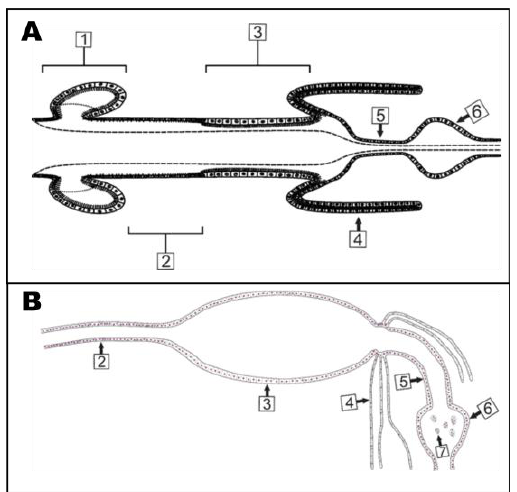
Figure 1. Anatomy of the larval and adult mosquito gut. ( A ) The larval alimentary canal is comprised of the foregut and cardia (not shown), GC (1), AMG (2), PMG (3), MTs (4), ileum (5), and rectum (6) (adapted from [5]); ( B ) The adult alimentary canal is comprised of the AMG (2), PMG (3), MTs (4), ileum (5), rectum (6), and rectal papillae (7).